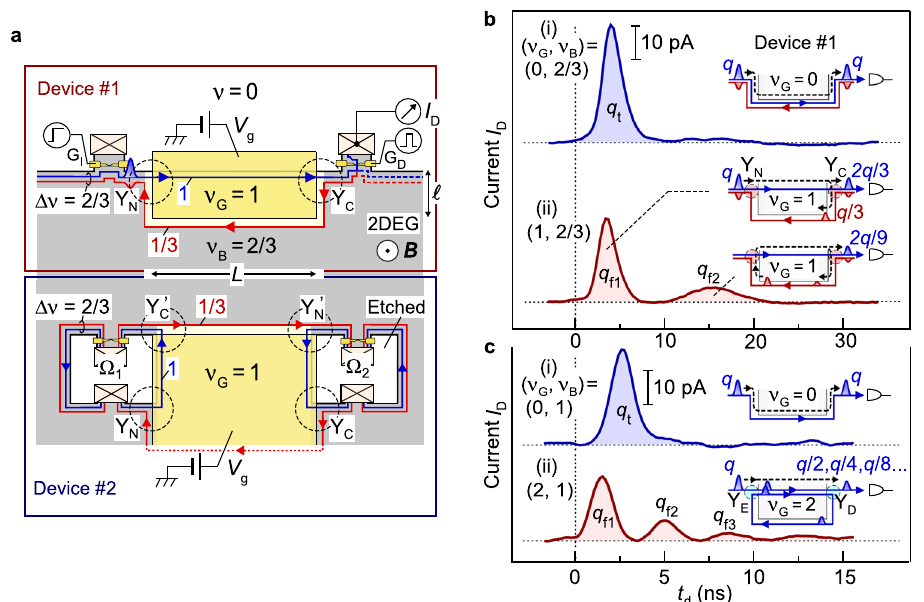
Fig. 2 Quantized fractionalization of charge wave packets. a Measurement setup with devices #1 and #2. Application of voltage V g to the large gate (yellow) forms a rectangular QH region ( L = 300 μ m and ℓ = 20 μ m for #1) and QH junctions Y N and Y C at ν G = 1 and ν B = 2/3. For #1, an initial wave packet is excited by applying a voltage step to the injector gate G I with the underneath fully depleted. Fractionalized wave packets are detected by applying a voltage pulse of width t w to transmit a part of the packet to be detected as current I D . For #2, two-terminal dc conductance G through similar Y-junctions is measured with ohmic contacts in Corbino geometry. b Typical charge waveforms obtained in current I D as a function of delay time t d of the detector voltage pulse with respect to the excitation voltage step. The reference trace (i) at ν G = 0 ( V g = − 0.3 V) and trace (ii) showing charge fractionalizations at ν = 1 ( V = 0.26 V) were obtained at ν = 2/3 ( B = 11.5 T). Areas under the peaks represent charges with ratios q G g B f1 / q t ~ 2/3 and q f2 / q f1 ~ 2/9. c The reference trace (i) at ν G = 0 ( V g = − 0.3 V) and trace (ii) showing fractionalizations at ν G = 2 ( V g = 0.34 V) obtained at ν B = 1 ( B = 7.5 T). The areas under the peaks show q f2 / q f1 ~ 1/2 and q f3 / q t ~ 1/4. Propagation of charge wave packets is illustrated in the respective